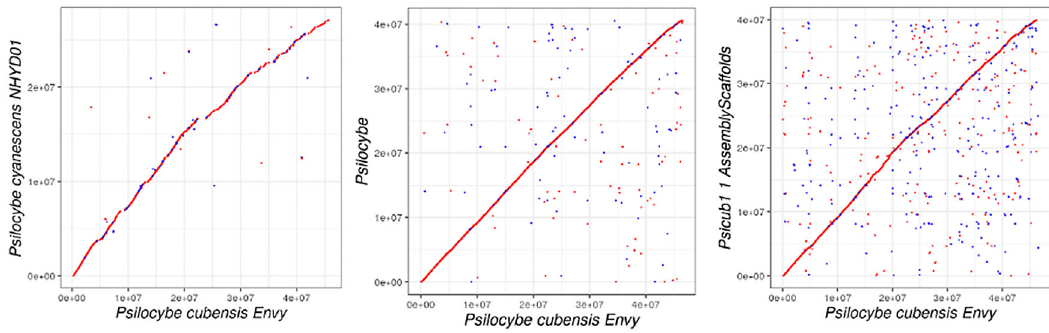
Figure2.WholegenomealignmentsofshortreadIlluminaassembliesto Psilocybe cubensis strainP.envy. Left